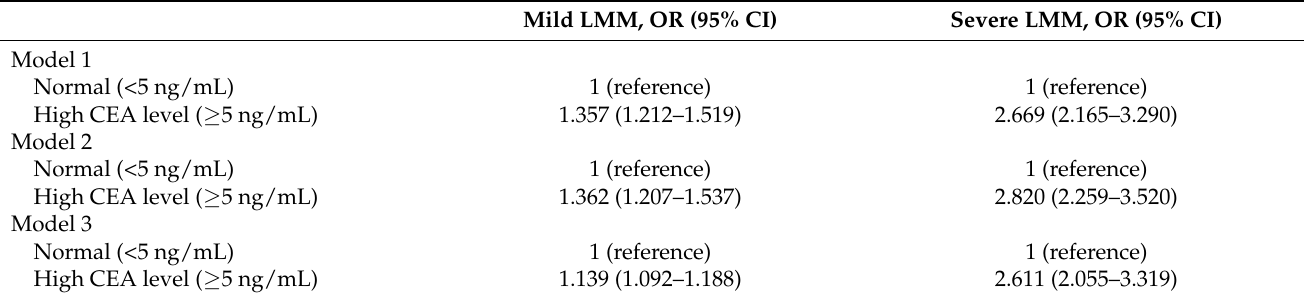
Table 3. Multivariate regression analyses showing associations of increased CEA with LMM.